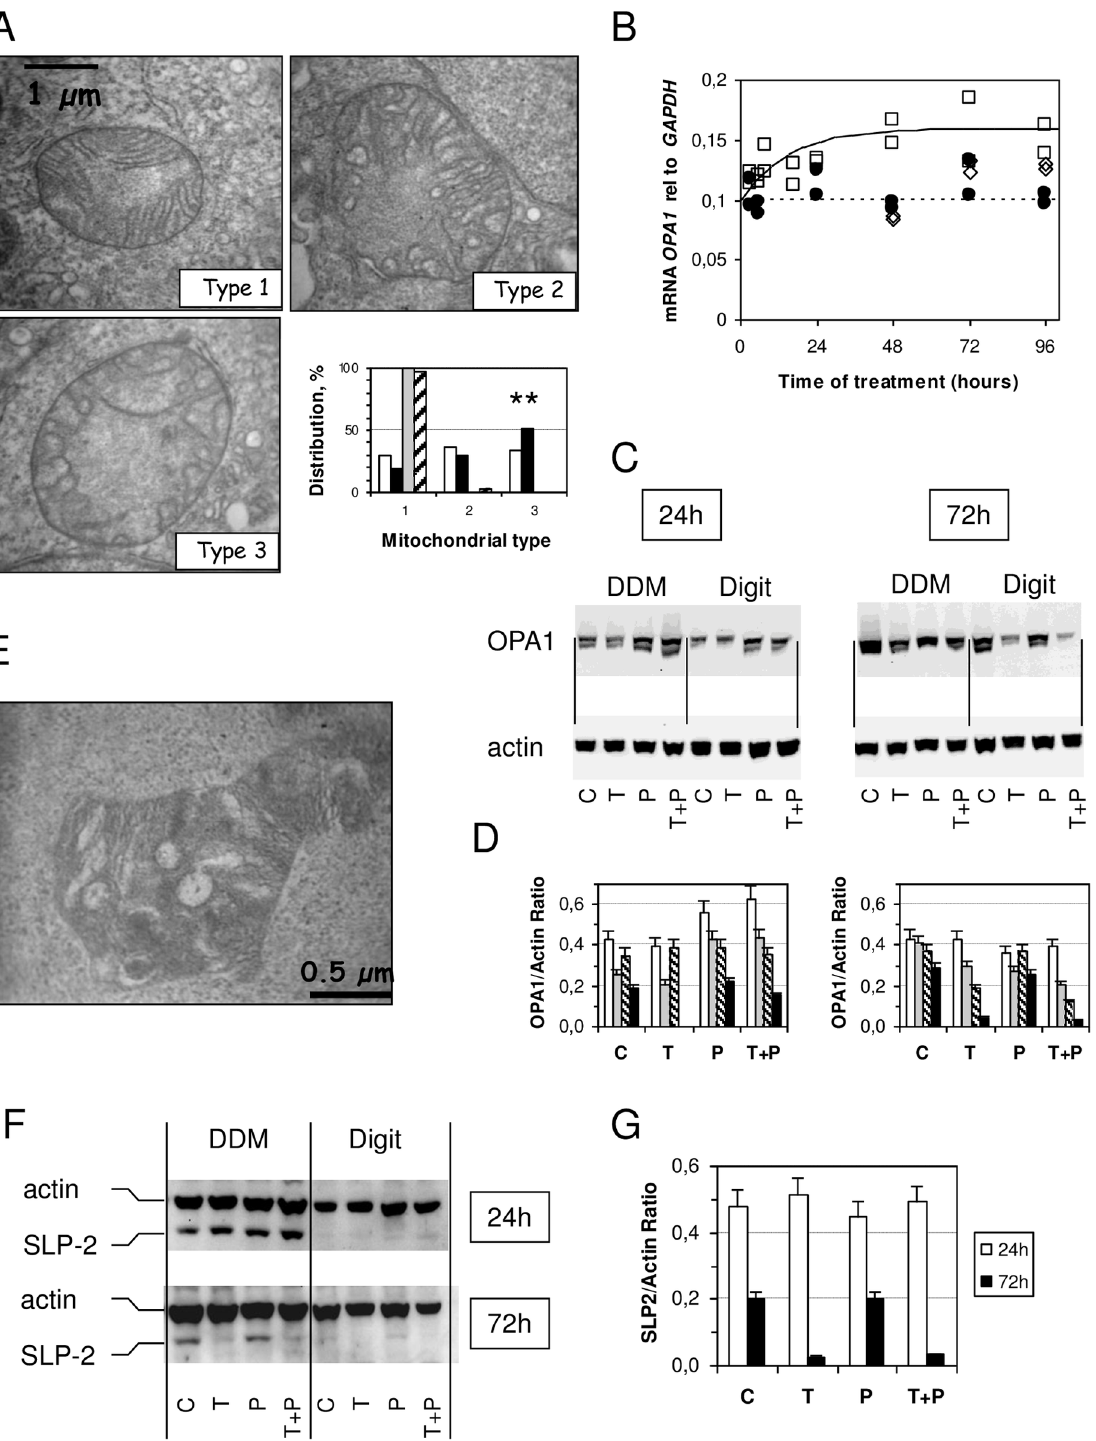
Fig 5. HT-29 cells ’ mitochondrial ultrastructure and proteins change upon TNF treatment. (A) Electron micrographs of different types of encountered mitochondria [62] and their distribution in control cells (open bars), in TNF-treated cells (black bars), in 1 μ M PK 11195-treated cells (grey bars), and in cells treated simultaneously with 10 ng/mL of TNF and 1 μ M PK 11195 (dashed bars). (B) OPA1 (optic atrophy 1) mRNA expression relative to GAPDH as a function of time of treatment with 10 ng/mL of TNF (open square), the simultaneous presence of TNF and PK 11195 (open diamonds), and controls without treatment (closed circle). (C) Western blot analysis of OPA1 protein in 0.1% dodecyl maltoside (DDM) and 0.1% digitonin (Digit)-solubilized mitochondrial